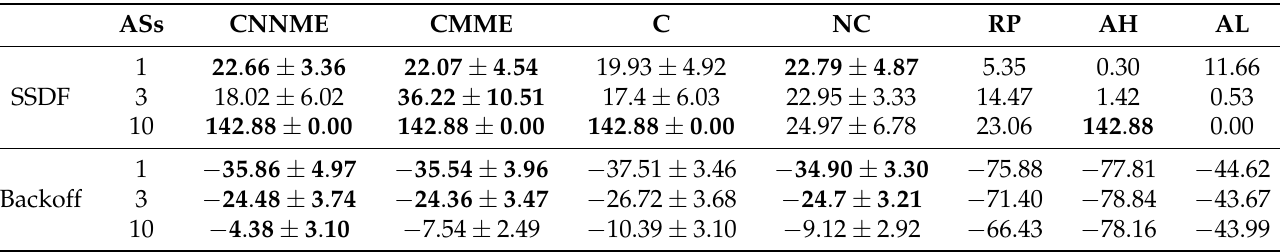
Table 2. Final rewards obtained for each combination of attack, number of ASs and setup. The values were obtained averaging 50 episodes for the best seed of each attack policy after training. We show the average reward ± one standard deviation. Bold entries show the best results, where a Welch test is used to detect whether means are significantly different for a significance level α = 0.01. Higher is better.